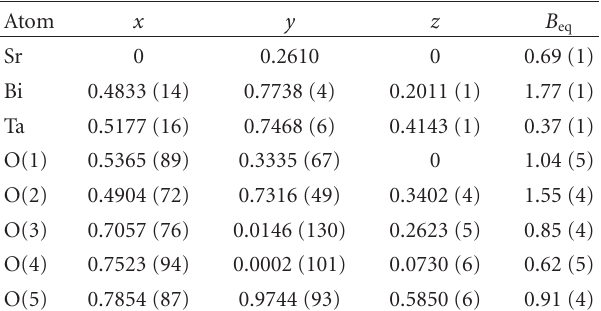
Table 1: Positional and thermal parameters of ferroelectric phase